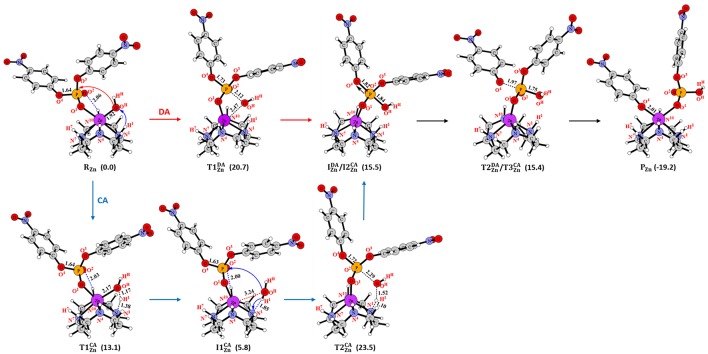
Structures (in Å) and energies (in kcal/mol) in the DAand CAmechanisms for Zn-C.